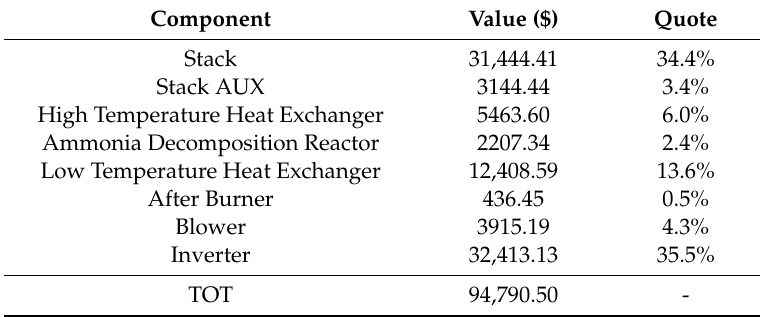
Table 14. Component costs of a 100 kW system operating in nominal